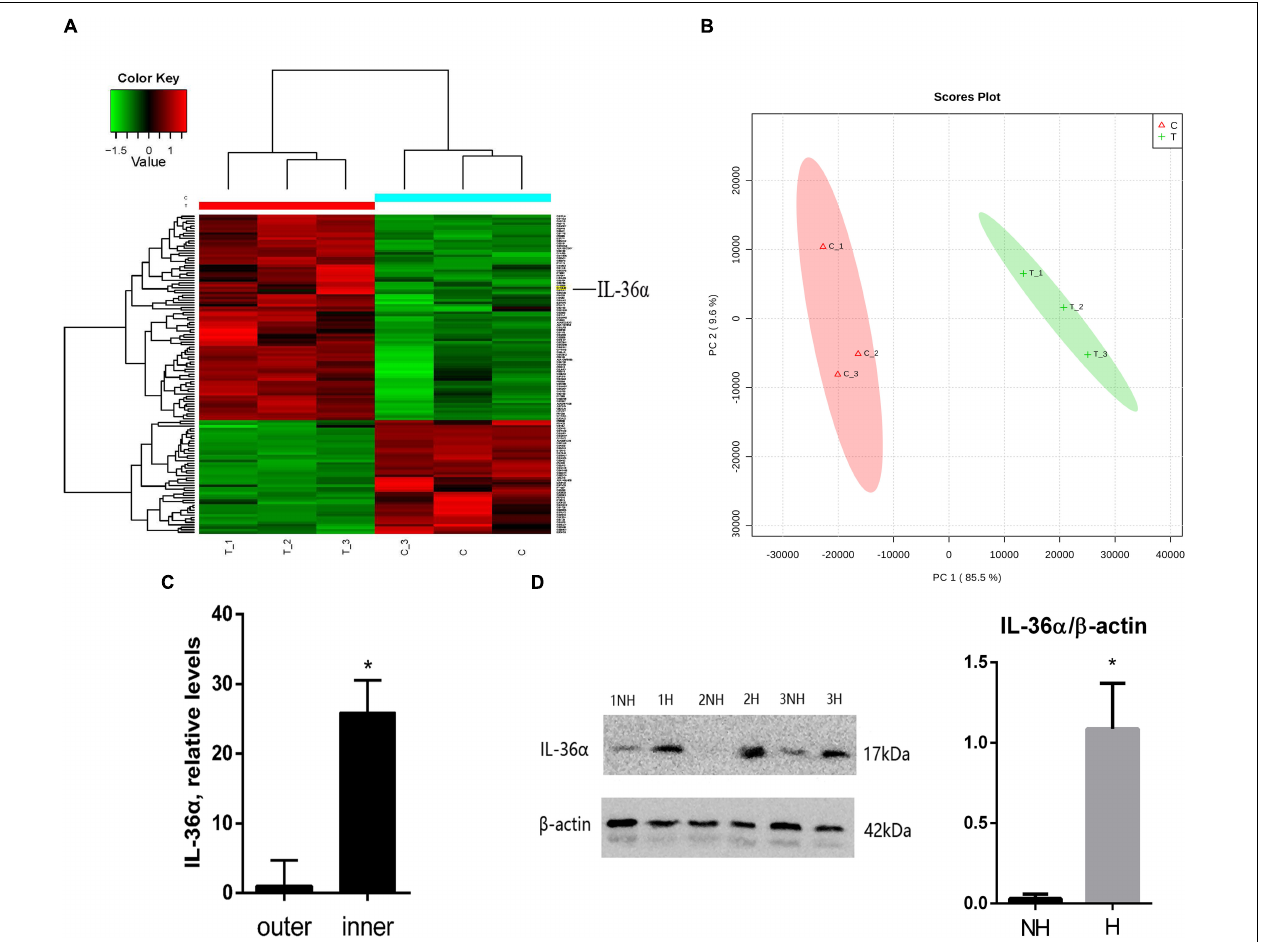
FIGURE 1 | Proteins differentially expressed between de novo hair follicle areas and no hair follicle areas within the scar region with upregulation of IL-36 α in the inner area of the wound. (A) Heat map representing 129 differentially expressed proteins between de novo hair follicle areas (inner) and no hair follicle areas (outer) within the scar region. (B) Principal Component Analysis (PCA) reveals distinct separation between tissue types (inner and outer scar areas). Real-time quantitative PCR (qPCR) (C) and western blot (D) analyzed the difference of IL-36 α expression between inner (H = de novo hair follicle area) and outer (NH = no hair follicle area) scar areas at post-wound day (PWD) 15 ( n = 3; * p <